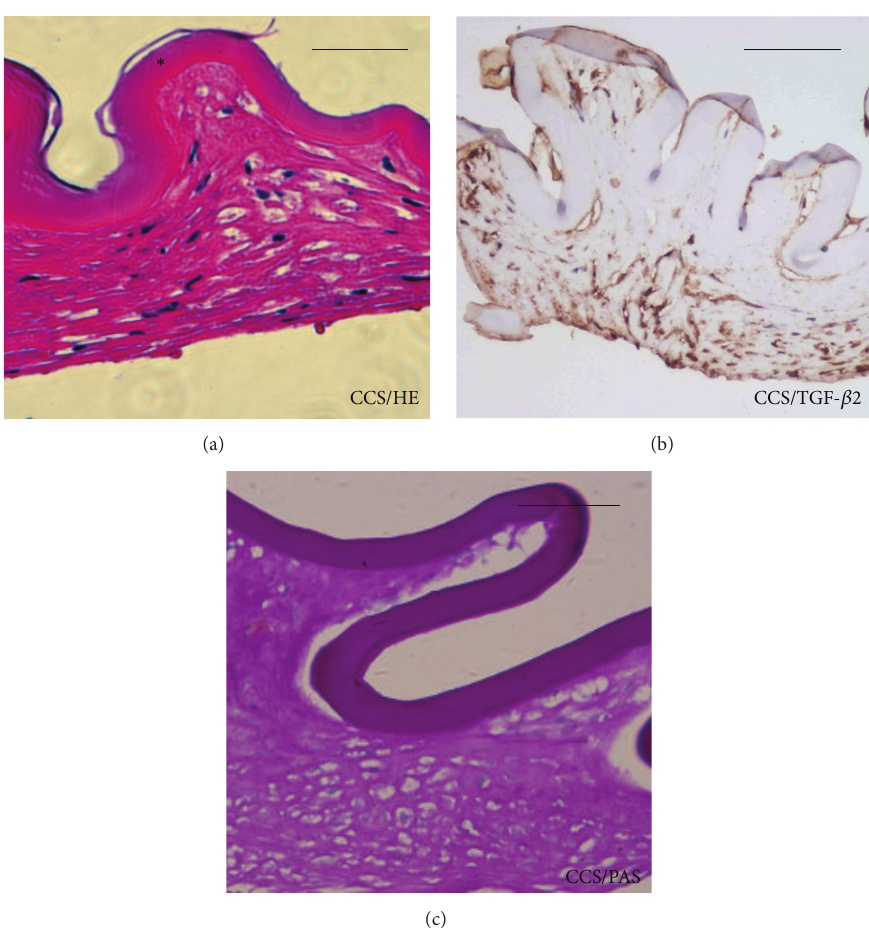
Figure 2: Histopathological analysis of the lens anterior capsular membrane in high myopic capsular contraction syndrome (CCS). HE and PAS staining revealed thickening of the anterior capsular membrane with spindle-like cells in high myopic CCS cases. Immunohistochemical staining of transforming growth factor- 𝛽 2 (TGF- 𝛽 2) in CCS cases showed diffuse intense signals located beneath the anterior capsular membrane (asterisk). Scale bar = 100 𝜇 m. CCS = capsular contraction